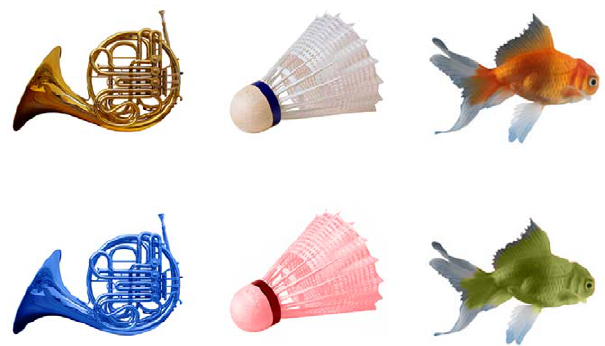
Figure 4. Examples of correctly (top) and incorrectly coloured